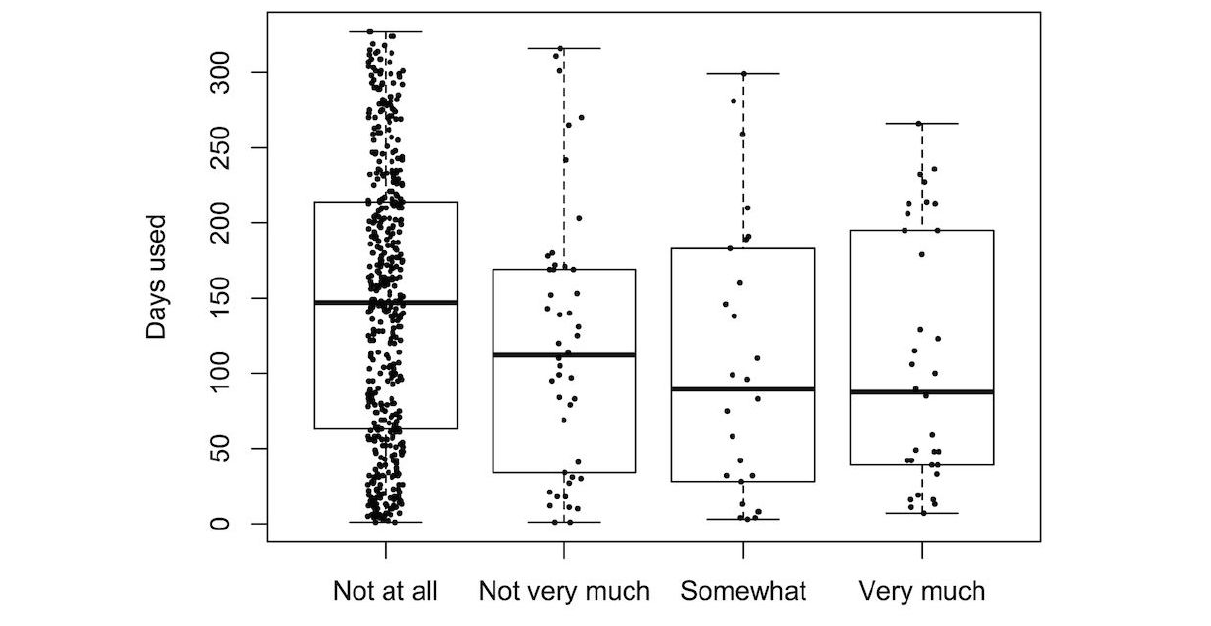
Figure 7. Boxplots of the distributions of Having the goal to quit smoking. Those not wanting to quit smoking (including non-smokers) have longer sustained use than those who